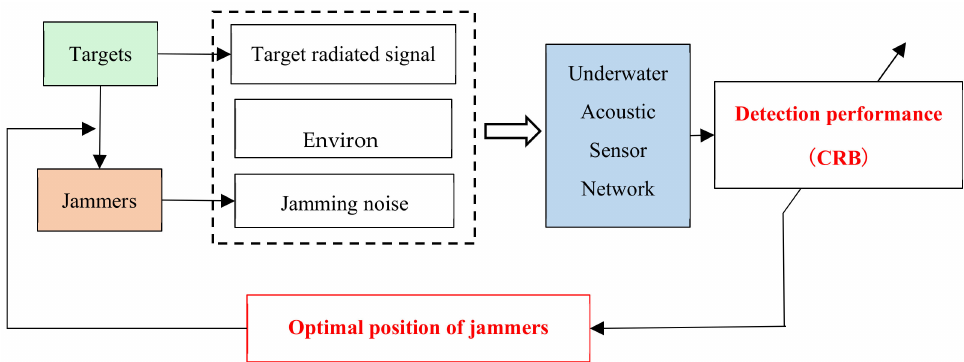
Figure 2. Model of optimal jamming layout strategy. CRB: Cram é Rao